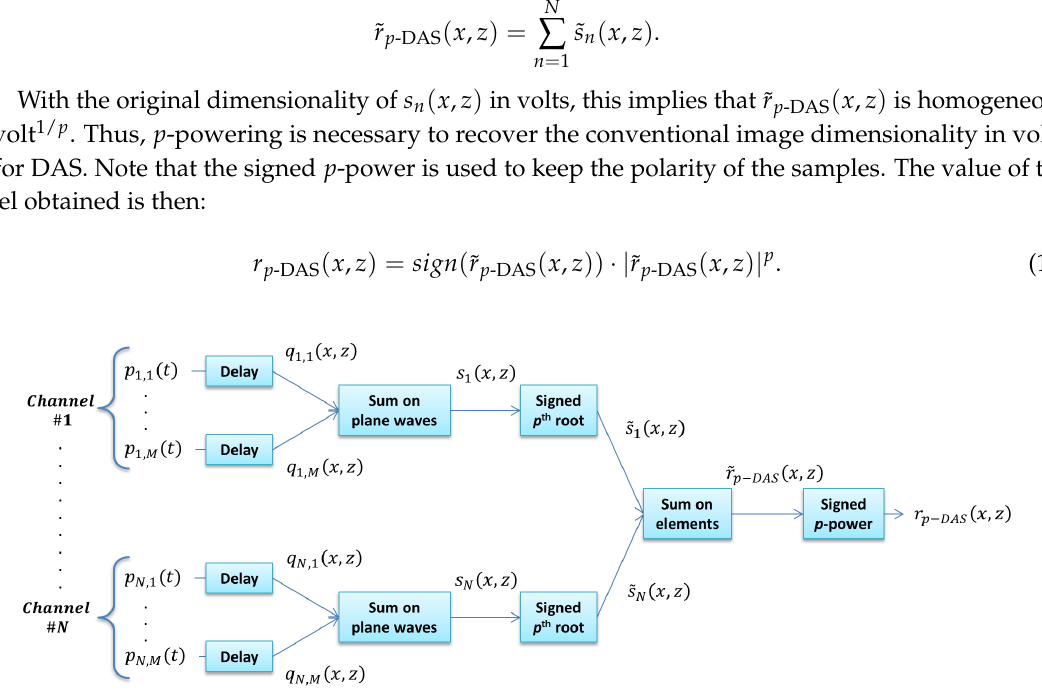
Figure 1. Block diagram describing how the value of a pixel r p -DAS ( x , z ) is obtained from the N × M raw echo signals recorded after M plane wave transmissions, using the N channels of the probe. Once all the pixel values have been computed in this way, a band-pass filter (not represented here) centered at f 0 is applied along the z -dimension of the complete image, in order to remove potential artificial harmonics due to nonlinear